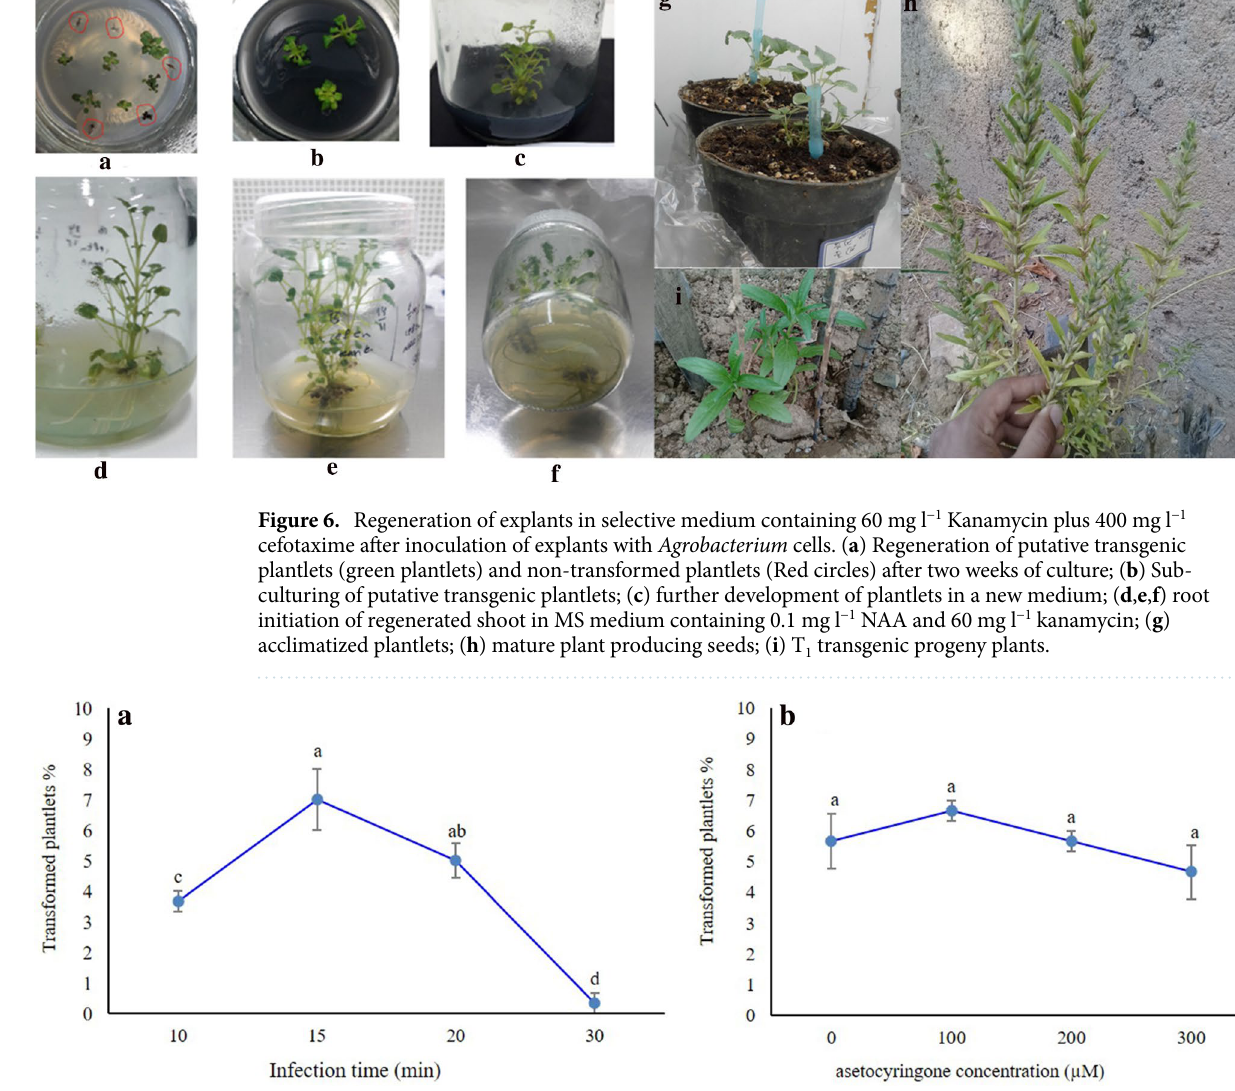
Figure 7. The effect of ( a ) different infection time and ( b ) concentrations of acetosyringone on gene transfer percentage. Means with only the same letters are not significantly different at the 5% level based on Duncan’s multiple range test ( p ≤ 0.05). Data shown represent means of transformation frequency ± SD ( n =